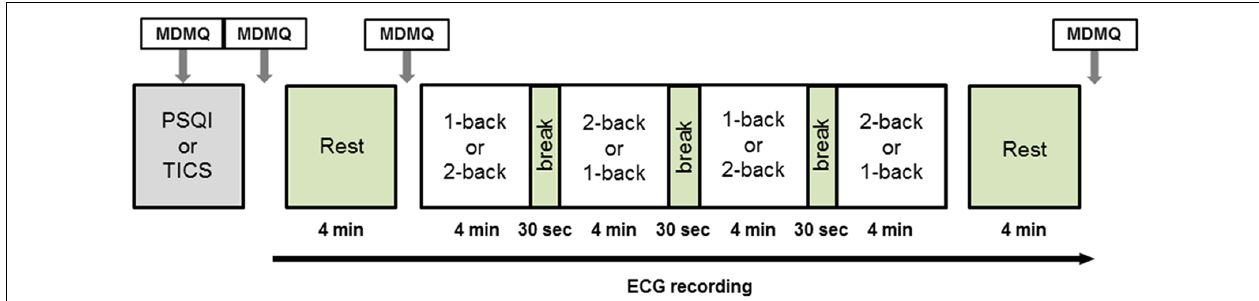
FIGURE 1 | Study protocol. Electrocardiography was recorded continuously from the beginning of the initial rest period to the end of the final rest period. The protocol was identical on both days of examination with the exception of